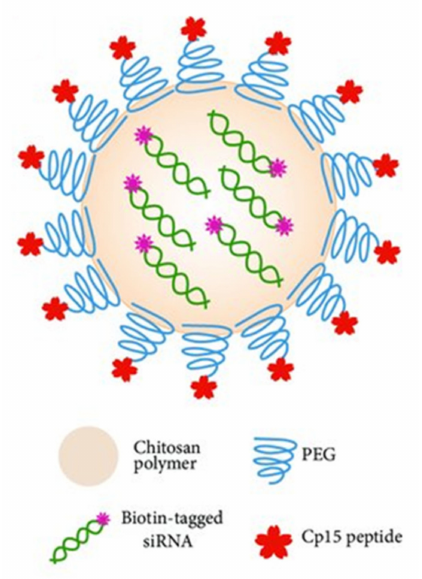
Figure 14. A nanoparticle formulation with a core formed by CS polymer, surface-functionalized with PEG, and a cell-targeting peptide (CP15). The formulation encases a biotin-tagged siRNA [109]. Reproduced with permission from Hindawi